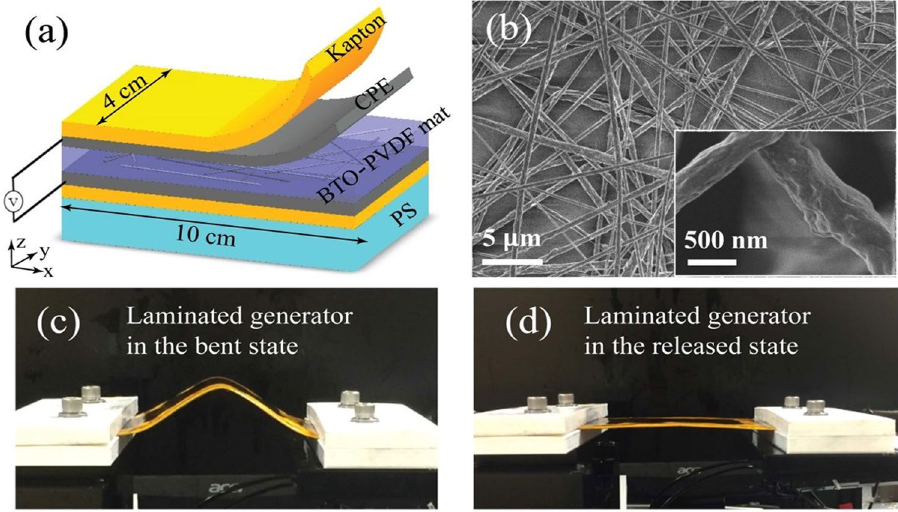
Figure 2. Design and performance of the laminated piezoelectric generators. ( a ) Schematic of a laminated BTO-PVDF generator that uses an electrospun piezoelectric mat. ( b ) SEM images of a BTO-PVDF